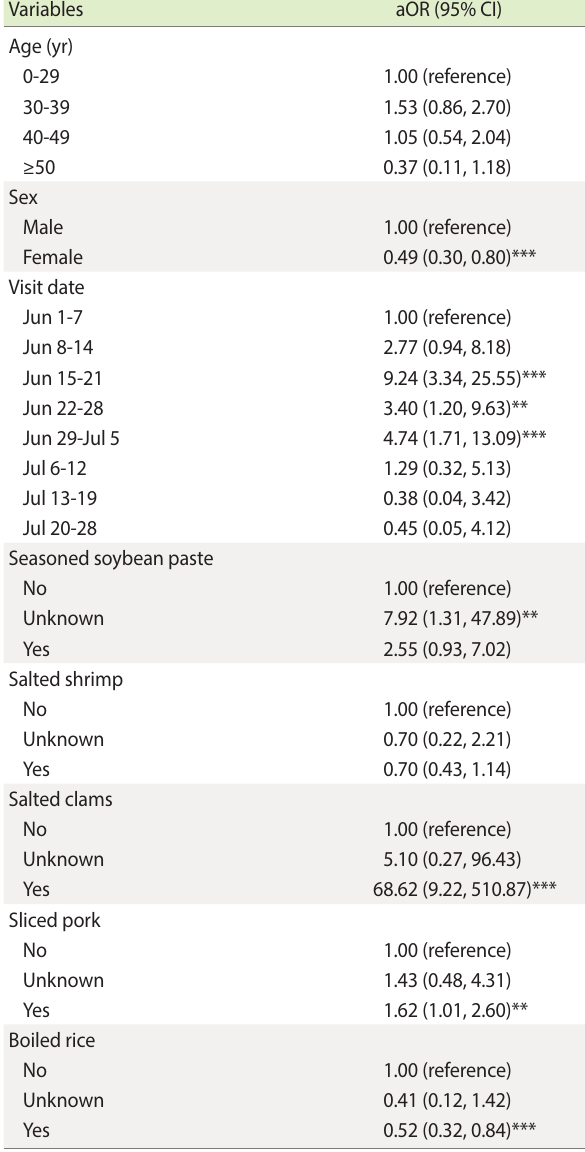
Table 3. Association between food consumed and hepatitis A cases